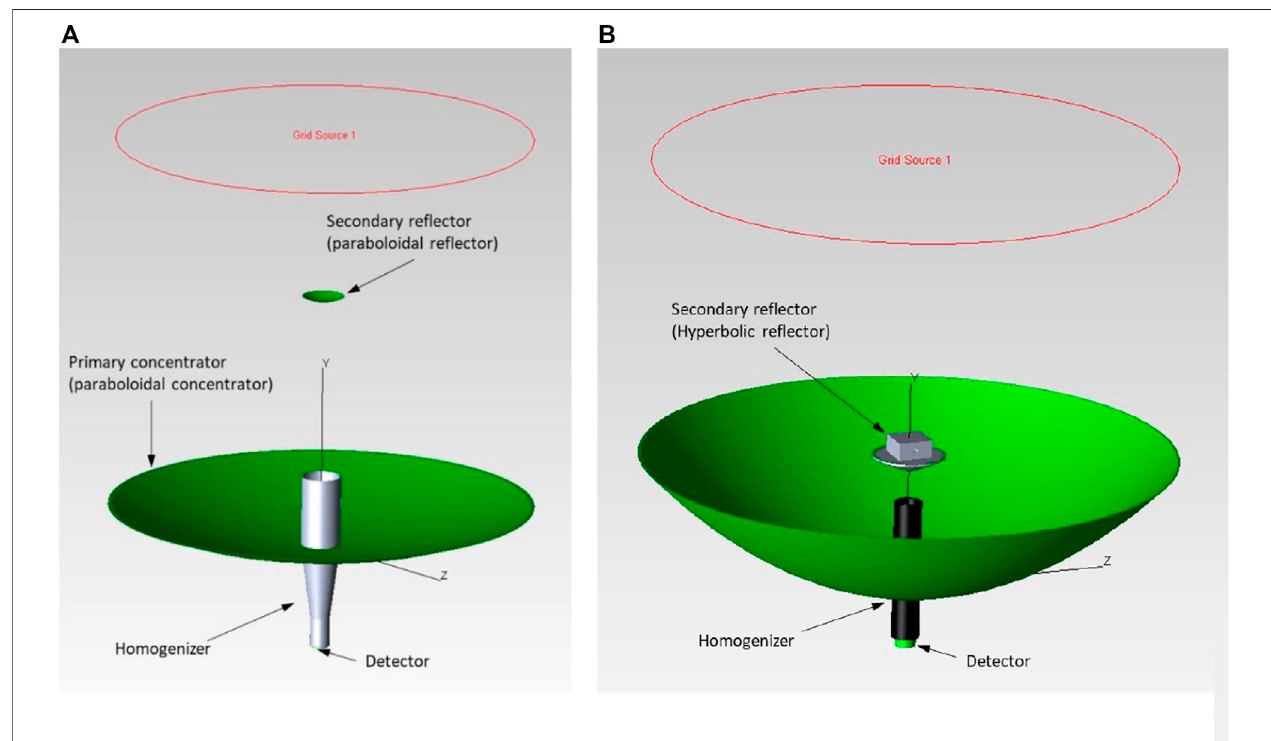
FIGURE 5 | 3-dimensional modeling of each component of the solar concentrator modules: (A) CM-1 and (B) CM-2.